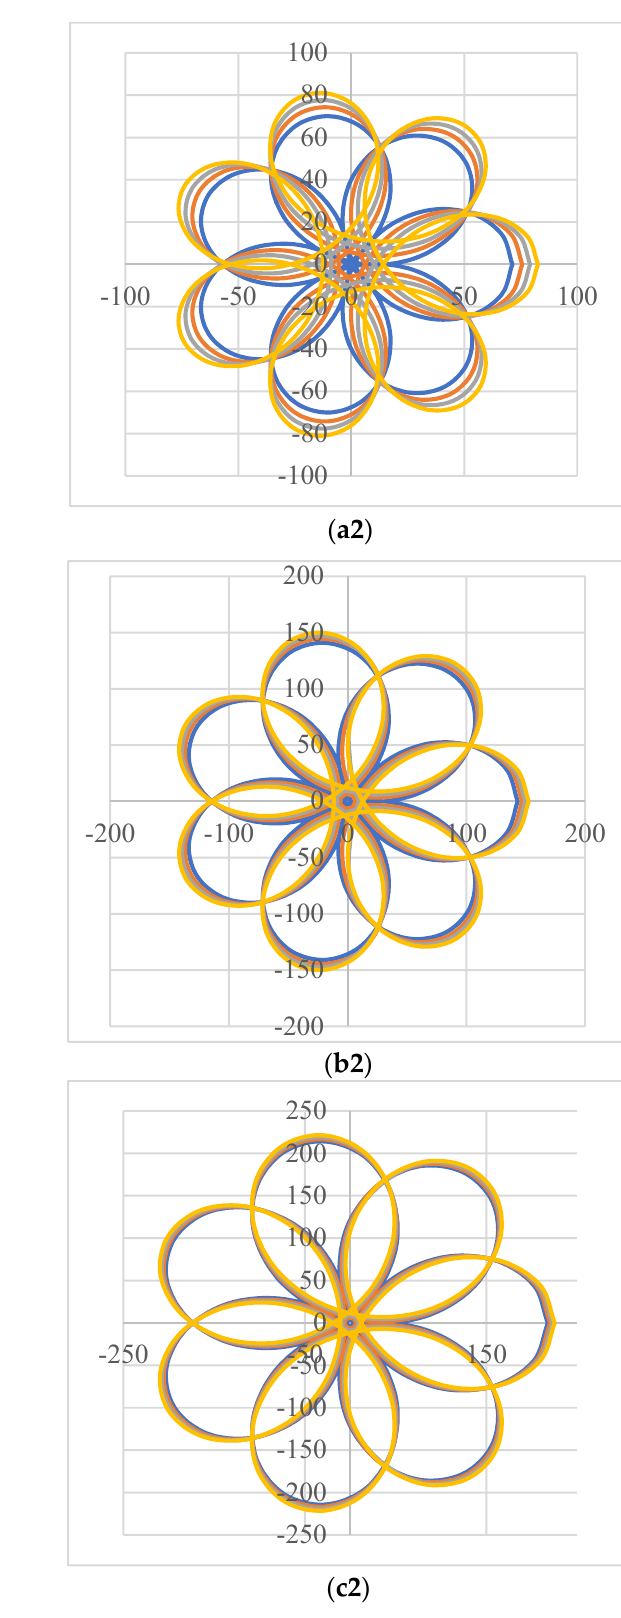
Figure 6. Study of the scan patterns produced by the configuration ba-ab of rotational Risley prisms (Figure 2d), for L = 1 m, e = 25 mm, and | M |= 6, with: ( a ) k = 1/2; ( b ) k = 2; ( c ) k = 3; ( d ) k = 5. ( 1 ) Left column, M > 0; ( 2 ) right column, M < 0. The values on the axes are in millimeters.